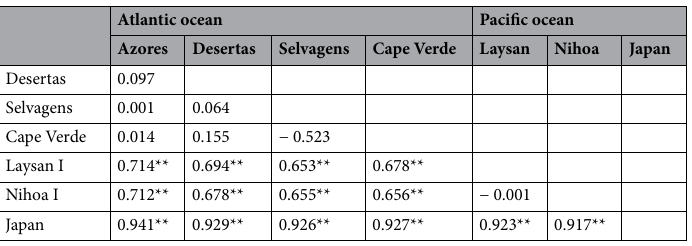
Table 2. Pairwise genetic differentiation of Bulwer’s Petrels, estimated by Φ st , between oceans and among island groups within oceans based on the mitochondrial locus NADH2. * P < 0.05, ** P < 0.001.